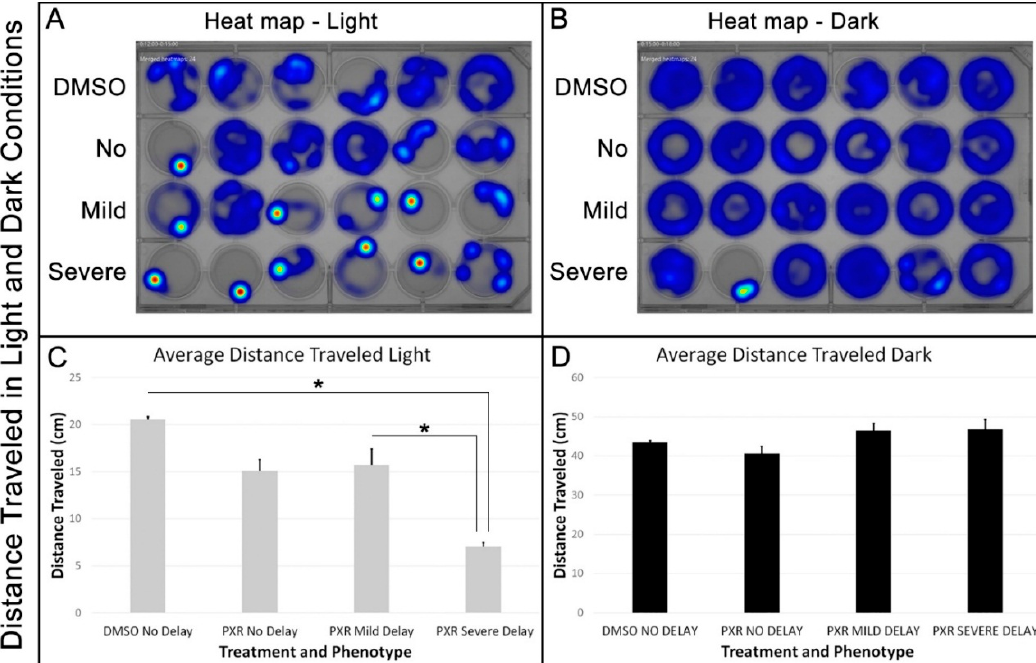
Figure 3. Zebrafish severely delayed by propoxur treatment showed greater aversion to light with less movement at 7 days postfertilization: ( A ) Heat map representation of the concentration of movement for each group during a single light interval; ( B ) heat map representation of the concentration of movement for each group during a single dark interval; ( C ) graphical representation of the average distance traveled for each group during the cumulative light intervals. The asterisks indicate a significant difference between the groups; and ( D ) graphical representation of the average distance traveled for each group during the cumulative light intervals.